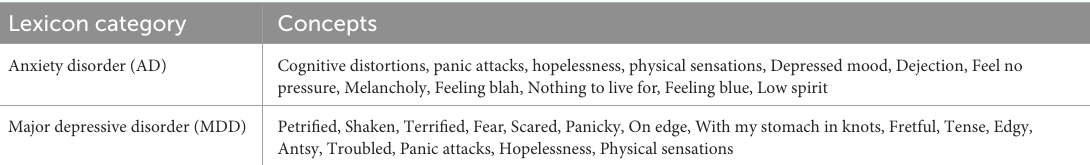
TABLE 3 A snapshot of safety lexicon to constrain question generation in depression and anxiety